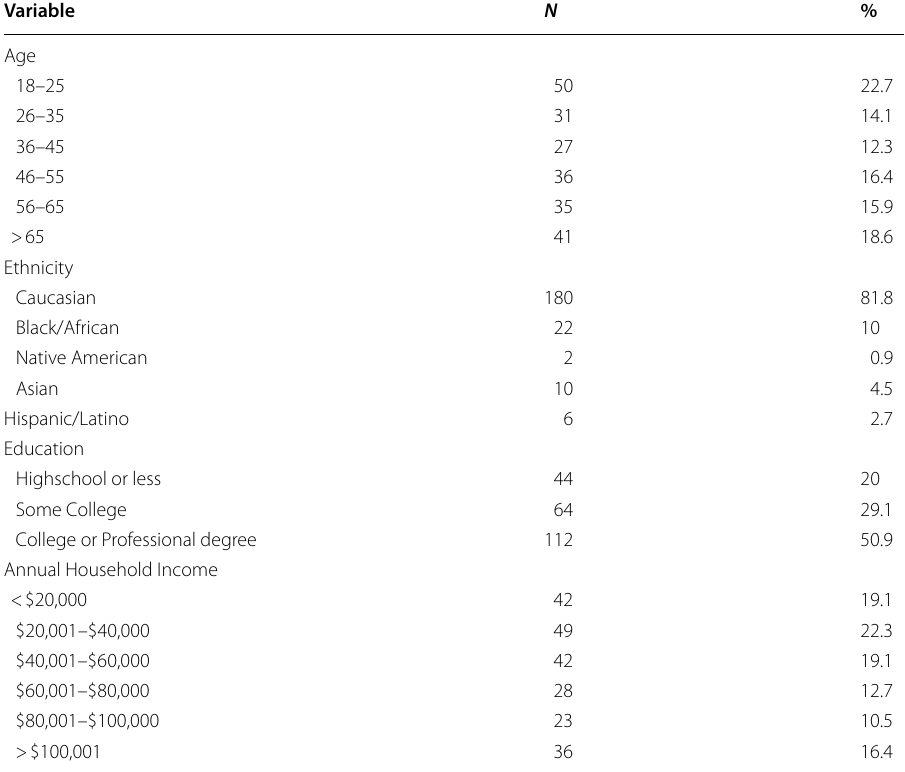
Table 2 Sample demographics: main